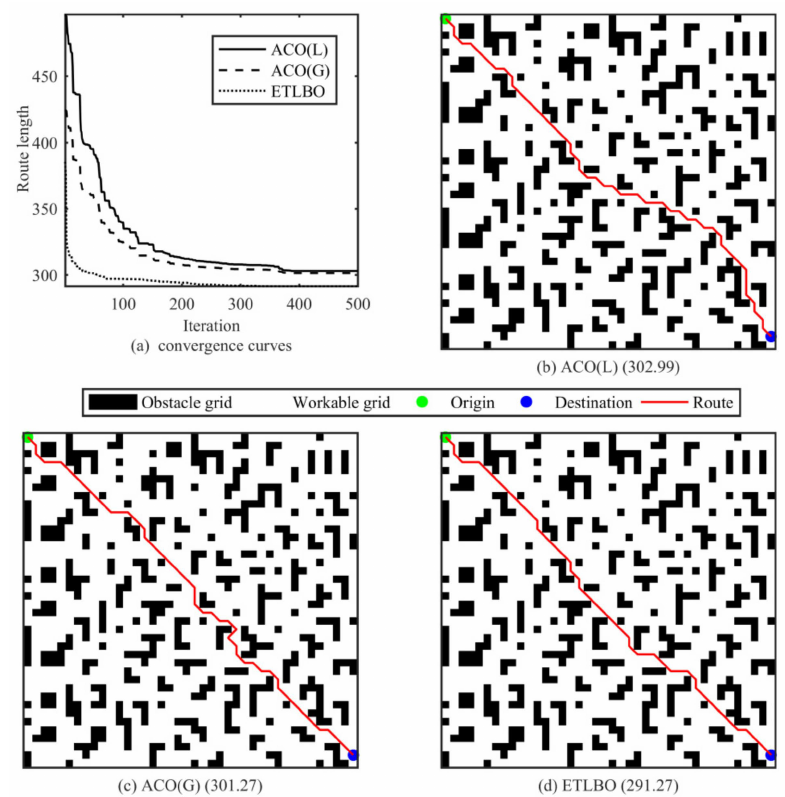
Figure 8. Best solution information of instance 40 ×